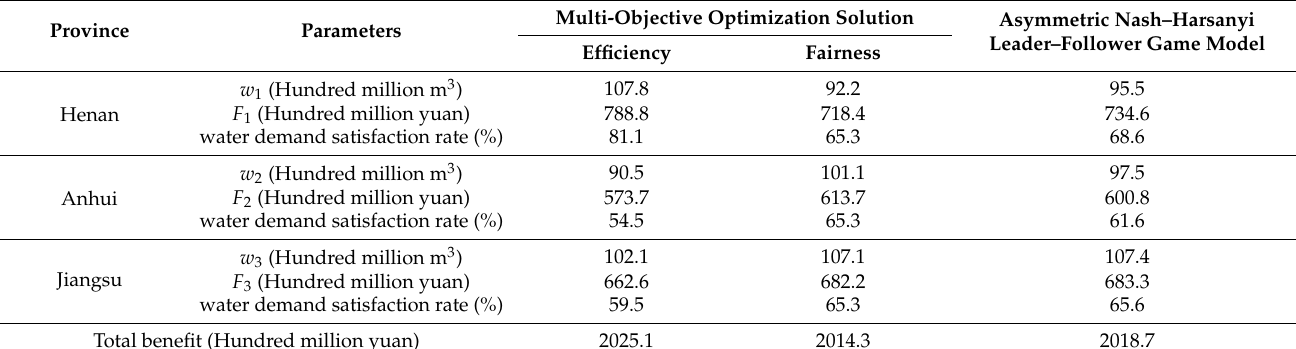
Table 3. Water resources allocation results under different